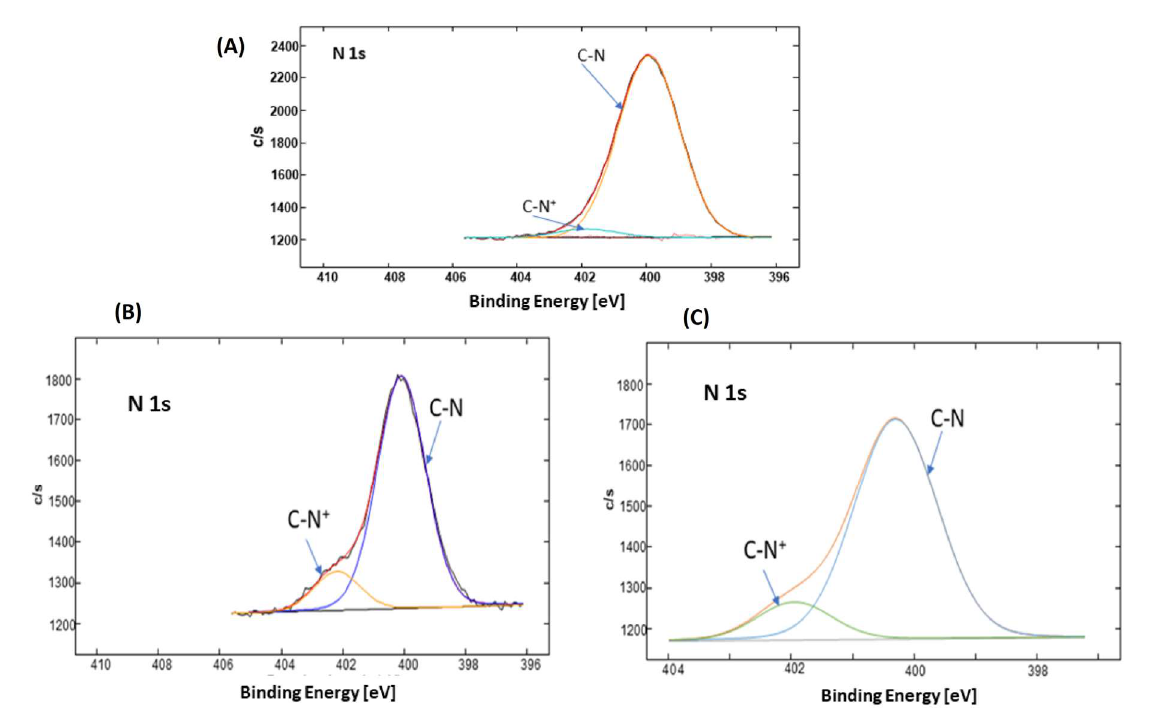
Figure 6. The N 1s core level XPS spectra of the star copolymer layers ( A ) before quaternization (sample SC-L) and ( B ) after quaternization with bromoethane (sample SC-LQ 2 ) and ( C ) after quater- nization with 1-bromooctane (sample SC-LQ 8 ).